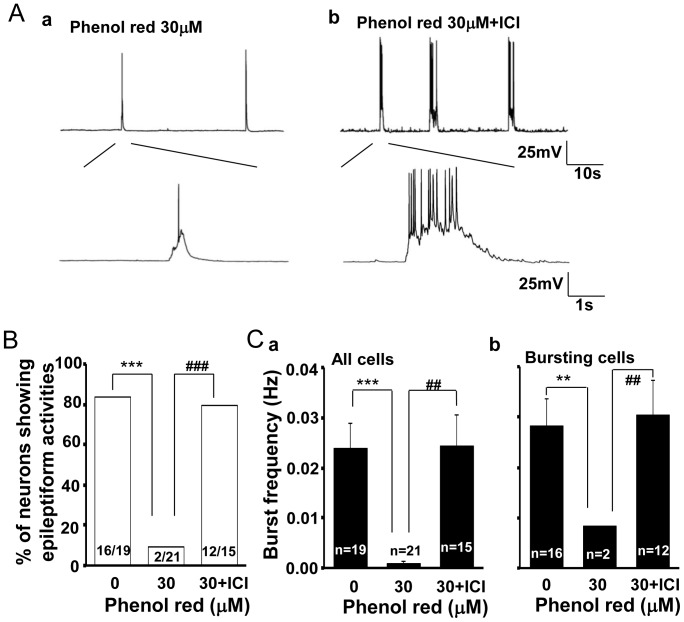
Estrogen receptor antagonist ICI 182,780 inhibits the suppressive effect of phenol red on the burst formation in cultured hippocampal pyramidal neurons.A. Electrical traces showing different spontaneous firing pattern in neurons cultured in medium containing either phenol red (30 µM) (a) or phenol red (30 µM) plus ICI 182,780 (100 nM) (b); B. Group data showing ICI 182,780 significantly (P<0.001) prevented the decrease of the percentage of the bursting neurons by phenol red at 30 µM; C. Group data analysis showing a significant blockade of the burst frequency by ICI 182,780 on the phenol red inhibition pooled either in all tested neurons (a) or in those bursted neurons (b). **, ##P<0.01; ***, ###P<0.001.